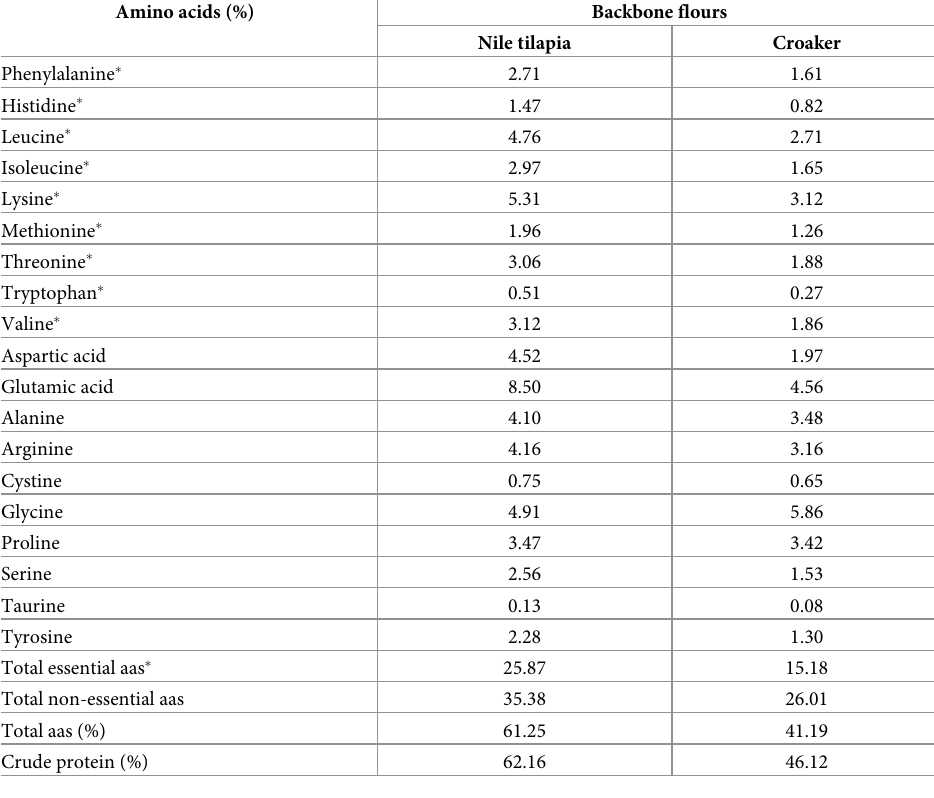
Table 3. Amino acid (aas) profile of Nile tilapia and croaker flours. Amino acids (%) Backbone flours Nile